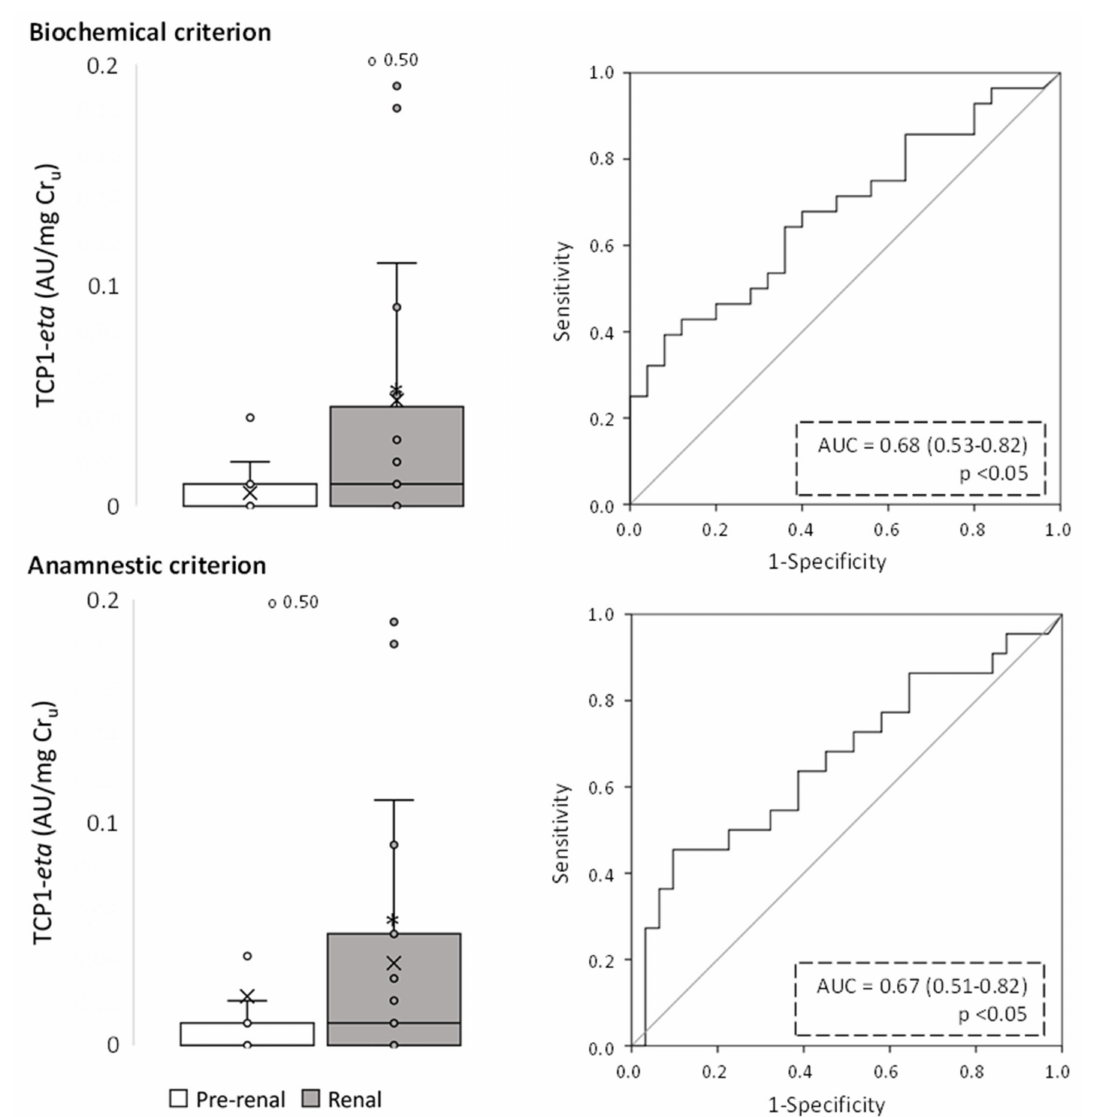
Figure 6. Urinary TCP1-eta levels of pre-renal and renal AKI patients following classification by biochemical and anamnestic criteria, shown as box plots ( left panels) representing median values in arbitrary units (AU) of urinary TCP1-eta per mg urinary creatinine (Cr u ), and ROC curves ( right panels). AUC: area under the ROC curve showing the pre-renal/renal classification efficacy of urinary TCP1-eta. The × in box plots represents the median value. *, p <